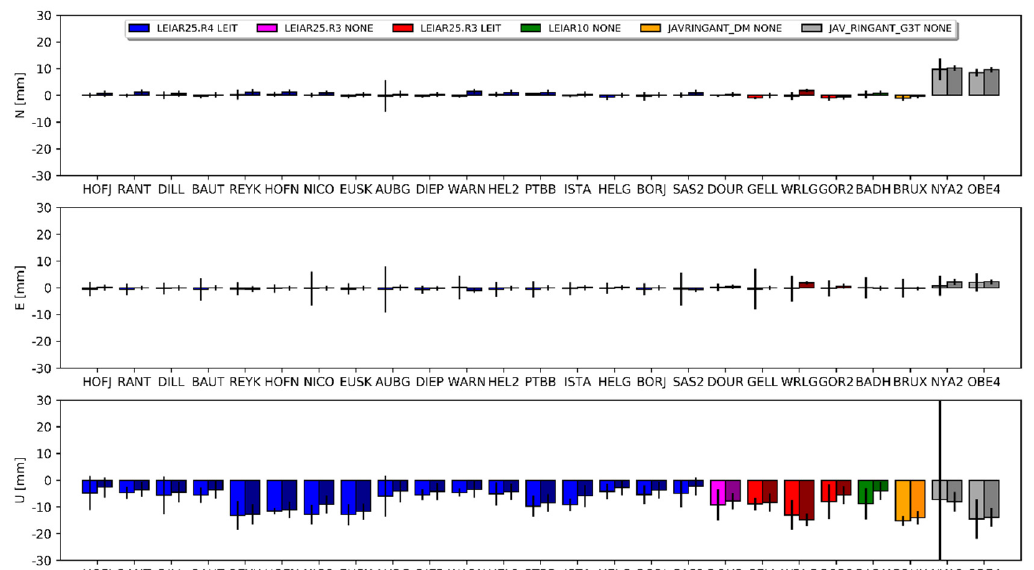
Figure 4. Coordinate differences between the E1 and E2 solutions and their standard deviations . Darker columns refer to the DD approach. Values are presented in Table A1 (Appendix A).